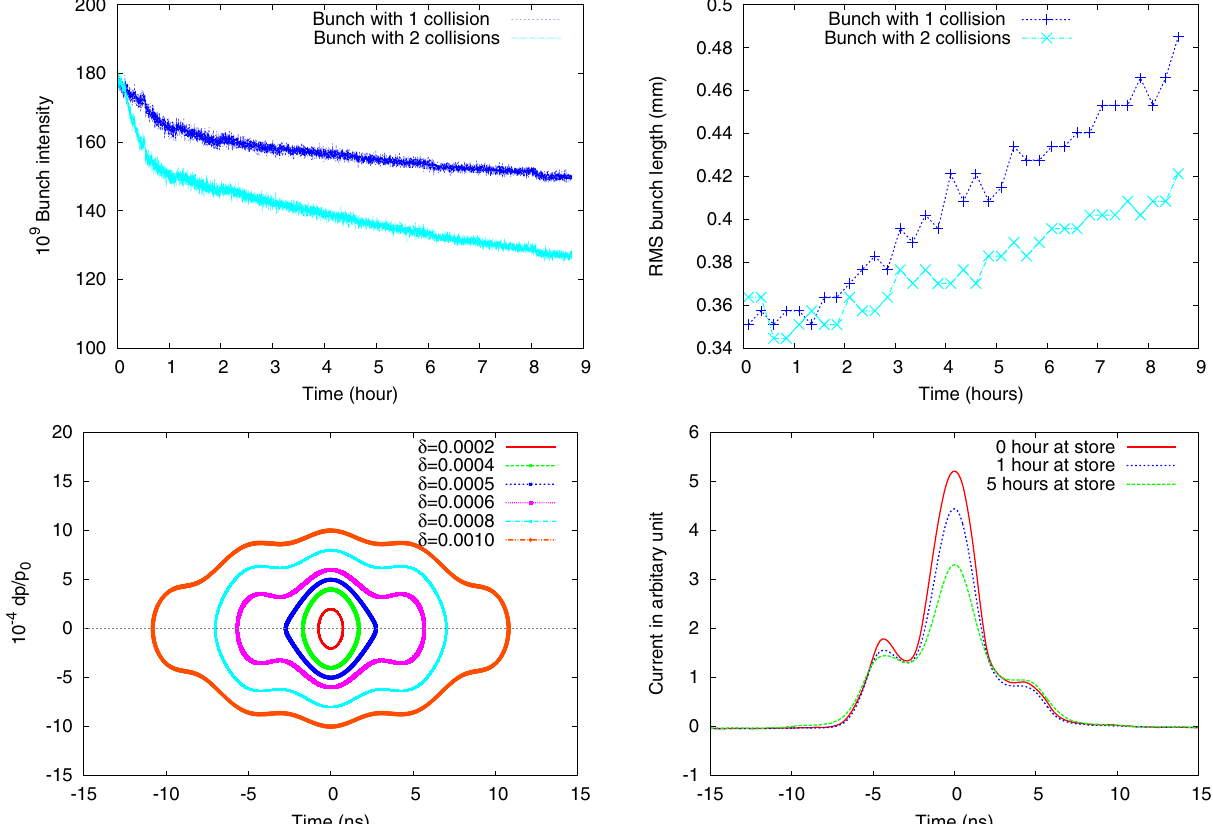
FIG. 8. Top-left: Intensity evolutions of two adjacent bunches, one with 1 collision per turn, the other 2 collisions per turn. Top-right: Bunch length evolutions of those two adjacent bunches. Bottom-left: Longitudinal phase space with 360 kV 28 MHz and 300 kV 197 MHz rf voltages. Bottom-right: The WCM measured longitudinal bunch profiles for the beam in the Blue ring of Fill 5 ns] is chosen arbitrarily. Choosing a different central region does not affect the following correlation.